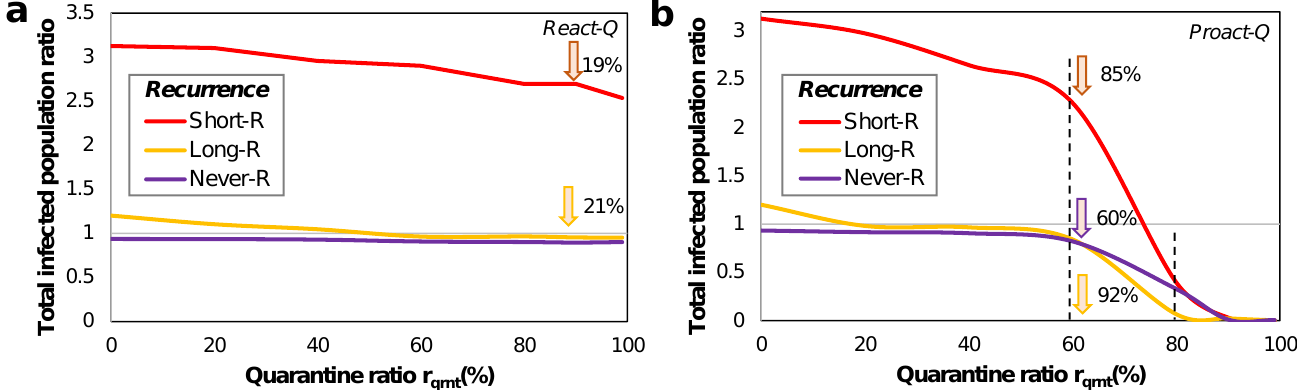
Figure 5. Impact of the recurrence scenario in terms of an increasing quarantine ratio r qrnt . ( a ) The total infected population ratio measured for a reactive quarantine policy. ( b ) The total infected population ratio measured for a proactive quarantine policy. The two vertical dotted bars delimit the phase transition area between r qrnt = 0.6–0.8; the respective decreases in the infected population ratios are displayed in relative percentage for each scenario of